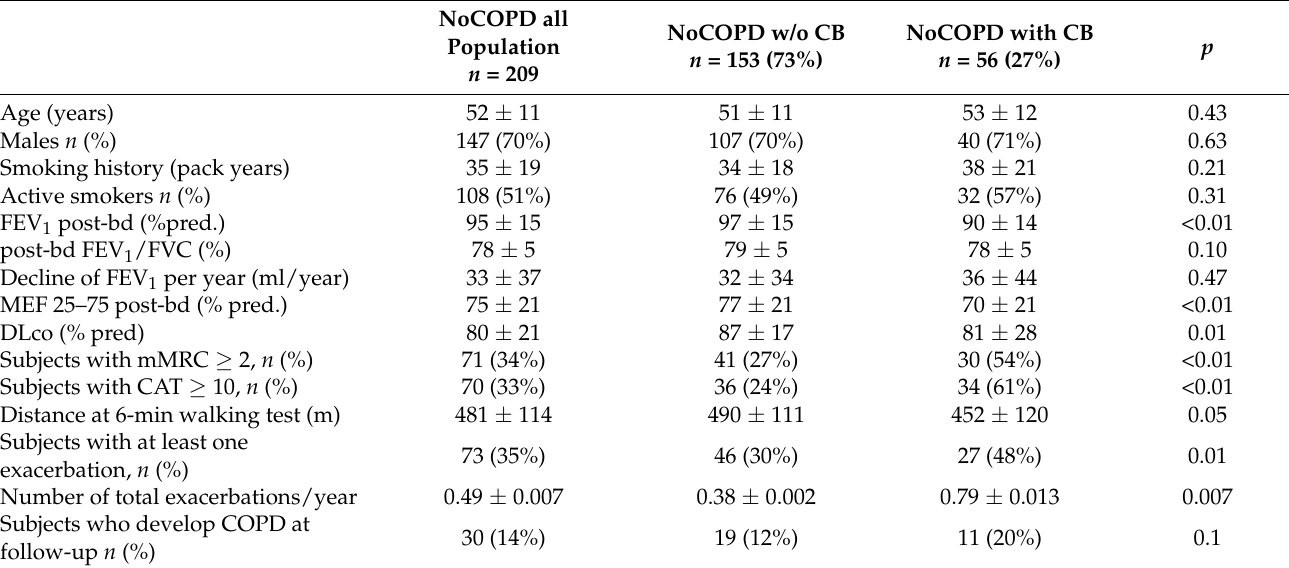
Table 1. Clinical characteristics of subjects without COPD